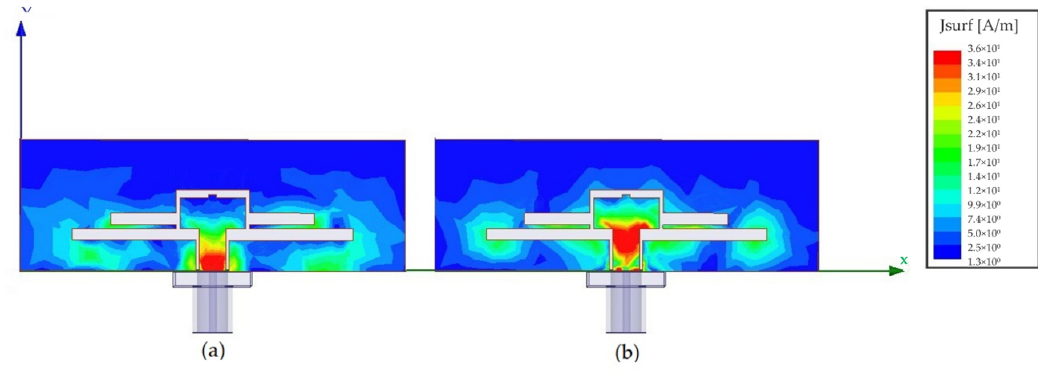
Figure 7. Simulated distribution current at ( a ) 2.1 GHz and ( b ) 5.9 GHz.